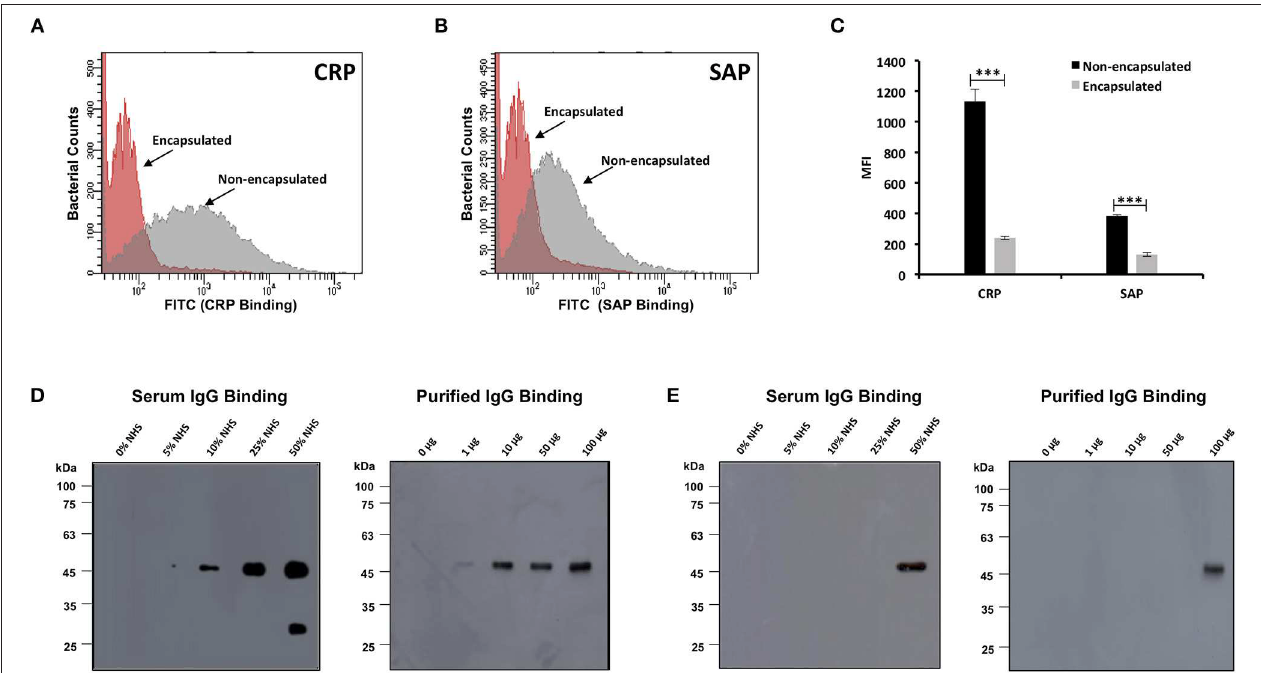
FIGURE 5 | Binding of complement mediators with encapsulated and non-encapsulated strains of Bacillus anthracis . Flow cytometry histogram for binding of pentraxins C-reactive protein (CRP) (A) and serum amyloid P component (SAP) (B) on B. anthracis strains incubated in 10% human serum. Gray and red shading indicates non-encapsulated and encapsulated bacteria, respectively. (C) CRP and SAP binding represented as mean fluorescence index (MFI) observed with non-encapsulated (black bars) and encapsulated bacteria (gray bars). Each bar represents the mean of three independent experiments. Error bars represent standard error of the mean. The scatter plots for the corresponding histograms are represented in Figures S4 , S5 . (D,E) Immunoblot assay for detection of human serum IgG and purified human IgG binding with B. anthracis non-encapsulated strains (D) and encapsulated strains (E) incubated with increasing concentration of normal human serum (5–50%) and purified human IgG (1–100 µ g/ml); 1% normal human serum and 10 µ g/ml of IgG was used as positive control. Statistical significance is highlighted by the following denotations: *** for P -value <